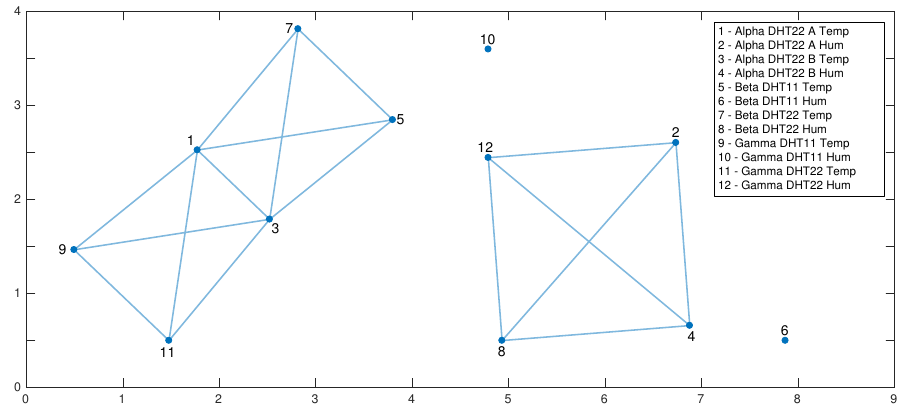
Figure 4. The estimated dependency graph for the considered test